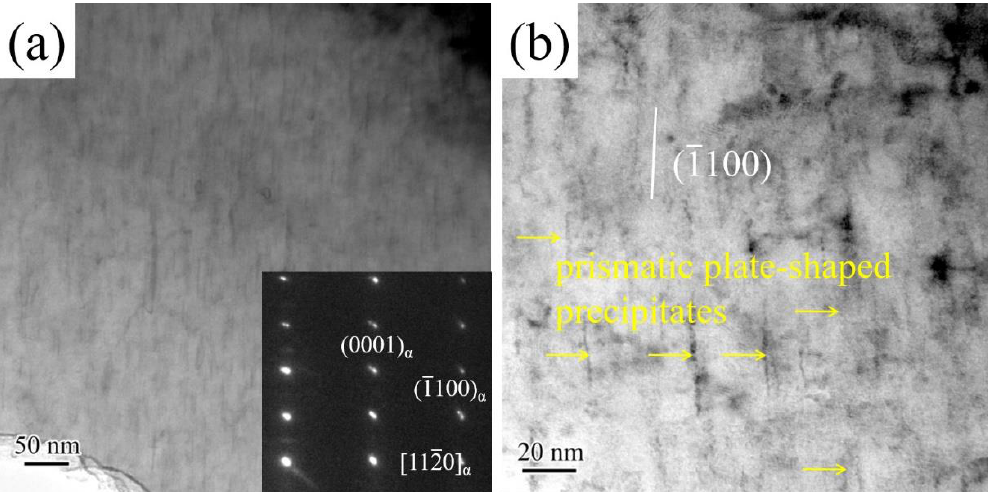
Figure 5. TEM bright-field image and SAED patterns of aged Mg-2.0Nd-2.0Sm-0.4Zn-0.4Zr alloy with solution treatment for 12 h, the incident electron beam direction is parallel to the [112 ̅ 0] α . ( a ) the low magnification TEM bright-field image, ( b ) the high magnification TEM bright-field image.